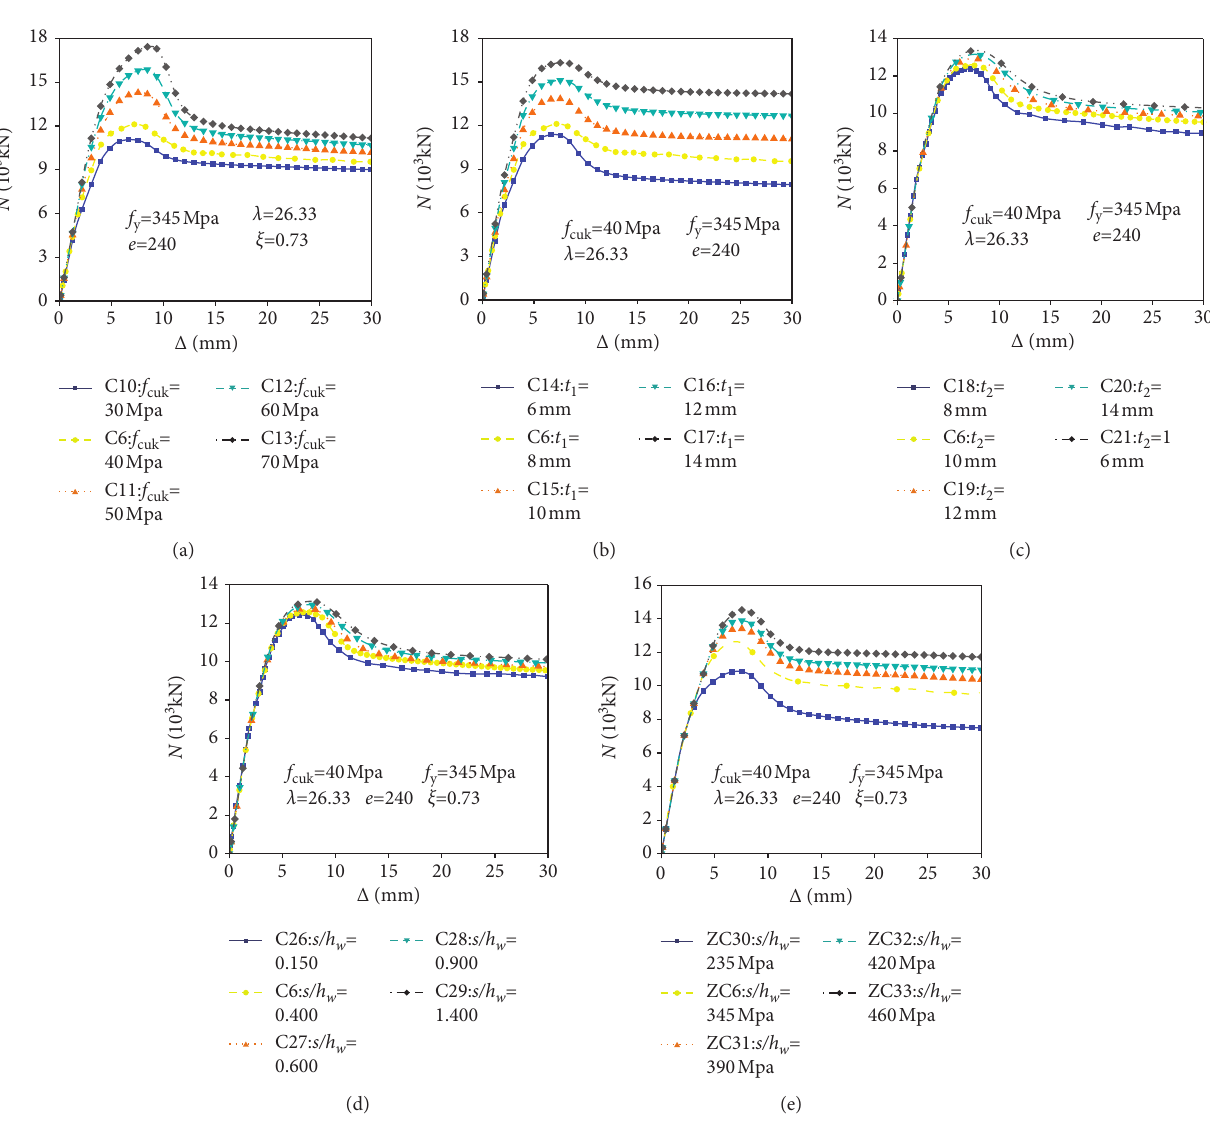
cuk . (b) t 1 . (c) t 2 . (d) s / h w . (e) f y